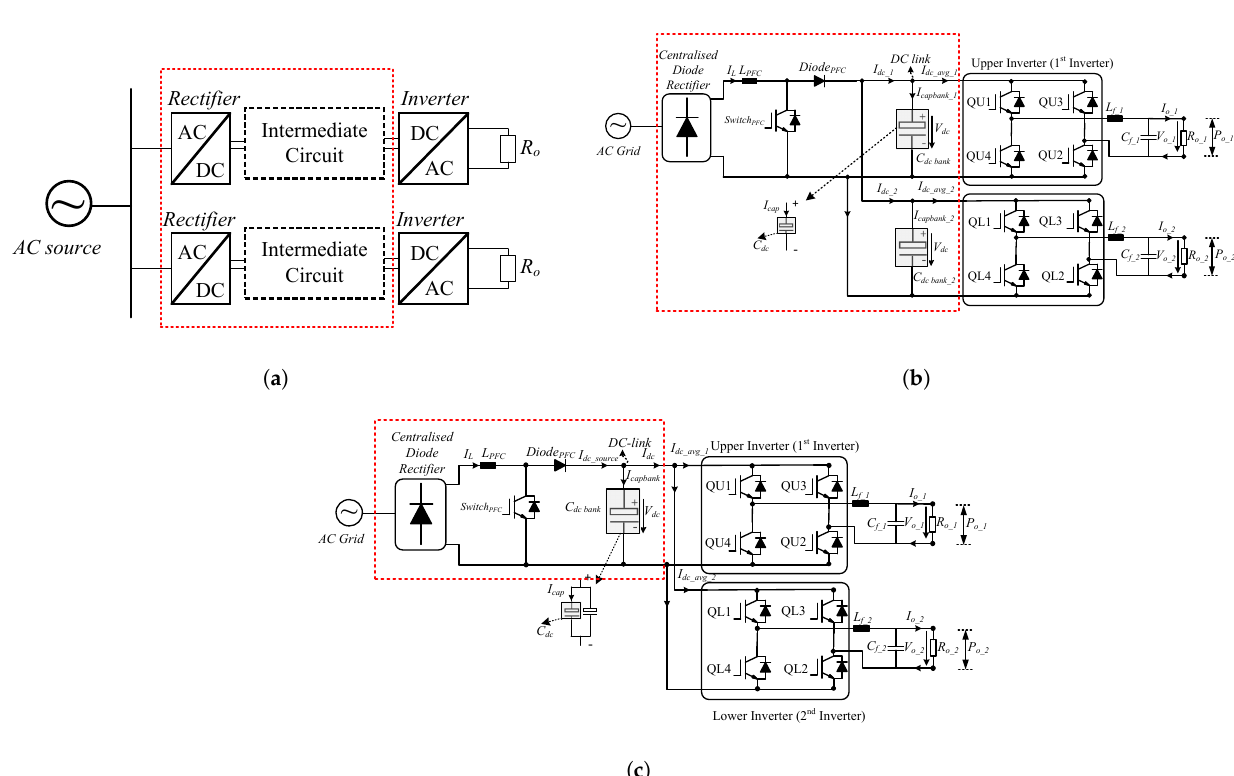
Figure 1. Schematic of: ( a ) the conventional parallel-connected system, ( b ) a multi-converter system with individual DC-bank having a centralized rectifier, ( c ) a multi-converter system with common DC-bank having a centralized